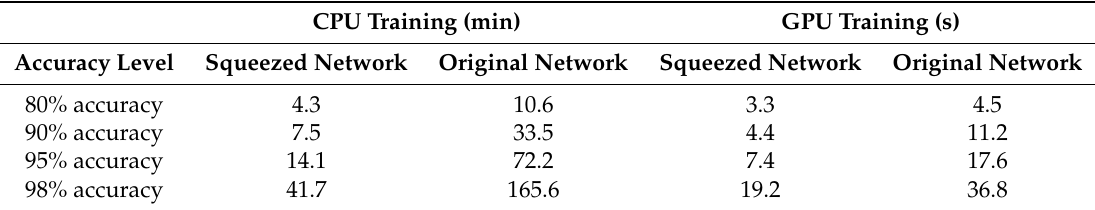
Table 2. Training time of squeezed network and original network in CPU and GPU.